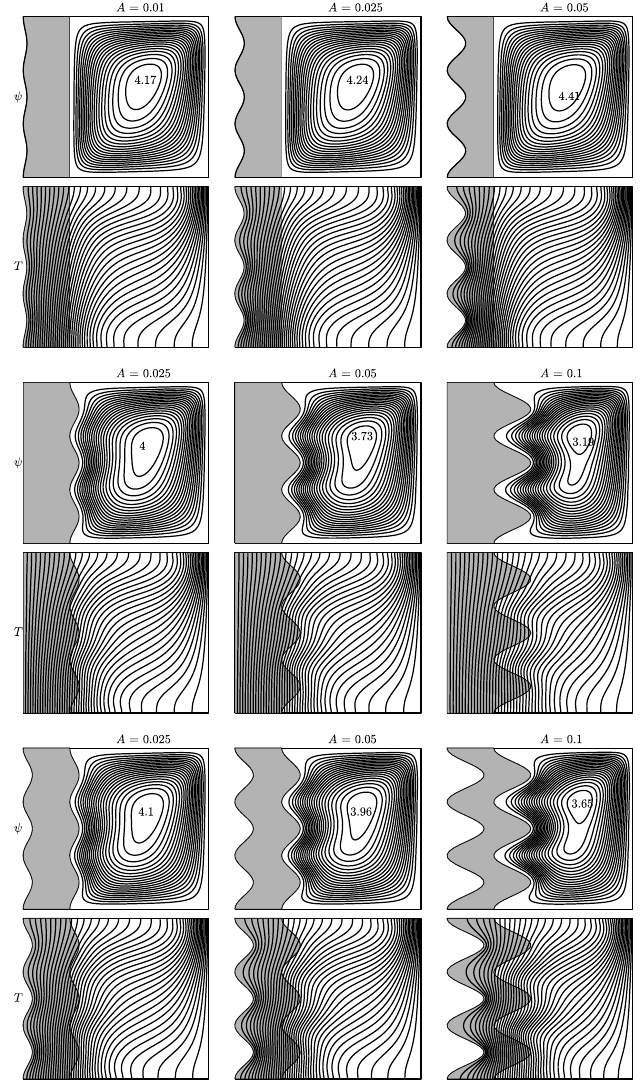
Figure 7. Variation in A when Ra = 10 5 , Ha = 25, kr = 1, γ = 0 ◦ , n = 3. Streamlines and isotherms at the ( top ) is for case 1, at the ( middle ) is for case 2 and the at ( bottom ) is for case 3. The impact of the number of waves in wavy wall is checked in Figure 8. In Case 1, | ψ | max stays almost the same in each n . In Cases 2 and 3, as n changes from 1 to 2 ,